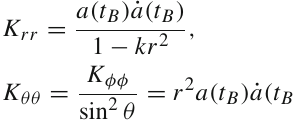
Fig. 4 The Penrose diagram for the model described in the case (b) shows distinct regions of space–time denoted as I, II+IV and III. Region I represents the modified OSD collapse, which is matched with an expanding FRW universe denoted by region II. The darker triangular region is the quantum gravity dominated region under which the col- lapsing and expanding space–times are joined. The exterior of region I is the vacuum Schwarzschild solution denoted by region III which is matched to a DeSitter universe denoted by region IV inside the horizon. In this model the expanding FRW universe and the DeSitter universe coincide. The dotted line in region I is the apparent horizon and the same in region II + IV are Cauchy